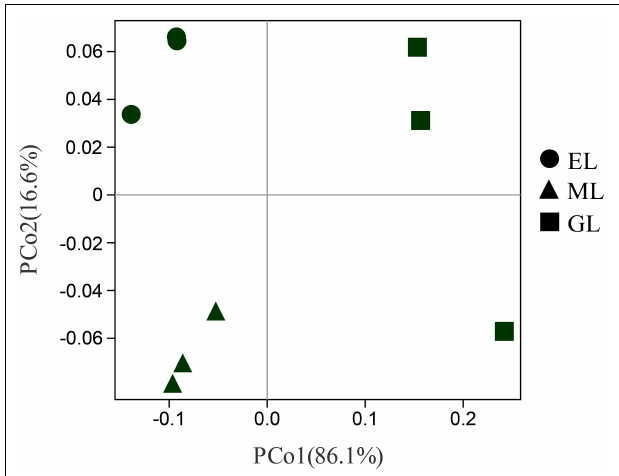
FIGURE 1 | Principal component analysis (PCoA) of plant communities in different land use types. EL, exclosure; ML, mowed land; and GL, grazed land.